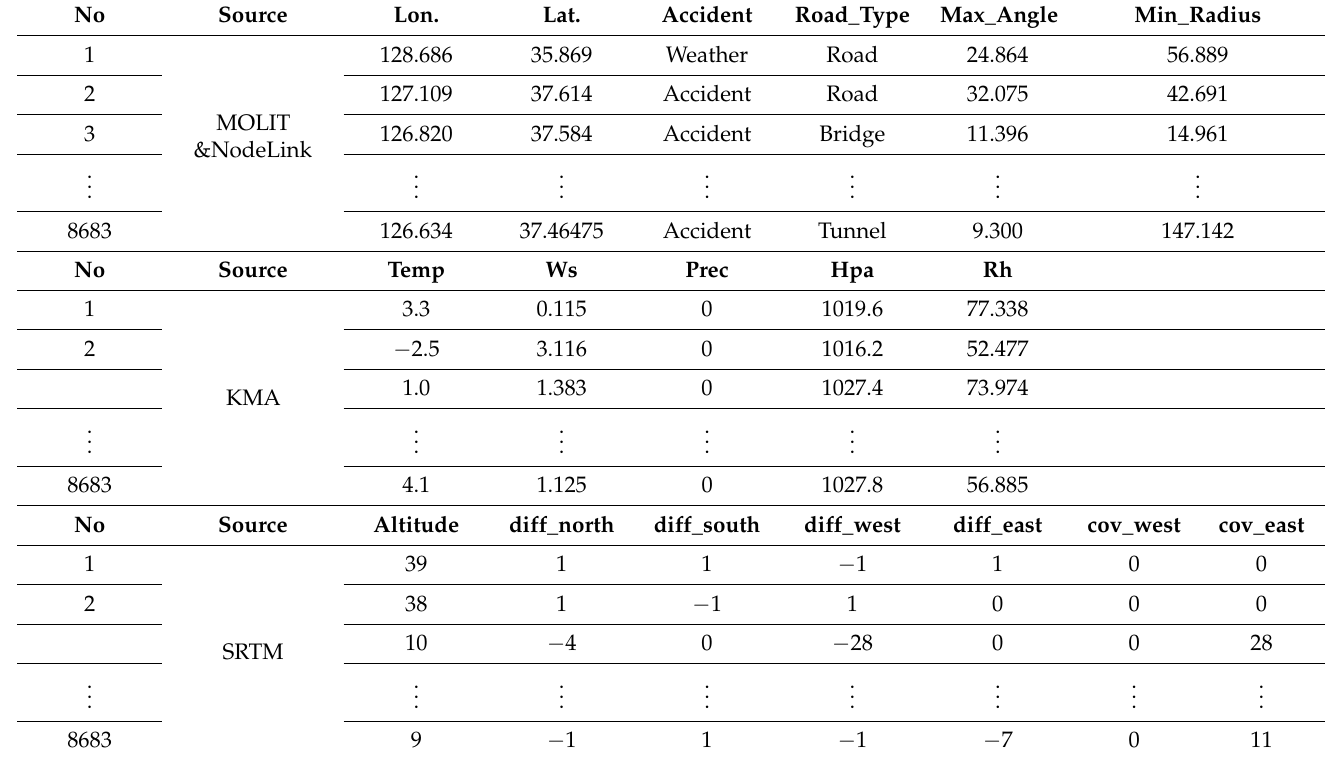
Table 1. Structure of the combined